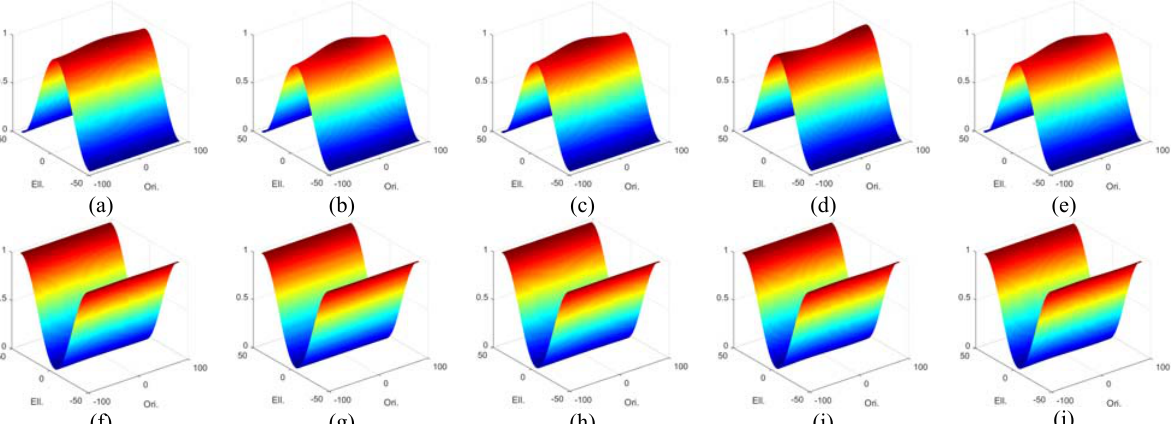
Figure 2. The polarimetric signature response of 5 trihedral CRs. (a)-(e) represent the co-pol responses from 331-1 to 331-5, and (f)- (j) represent cross-pol